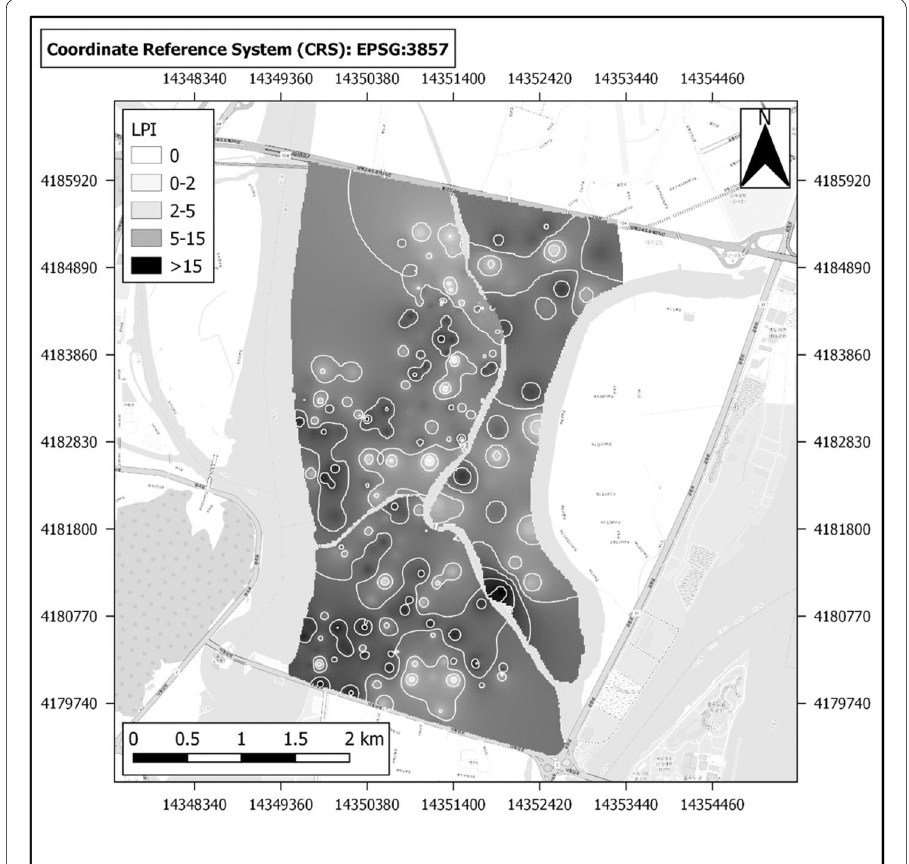
Fig. 15 Liquefaction hazard map based on Seed and Idriss [1] method for case